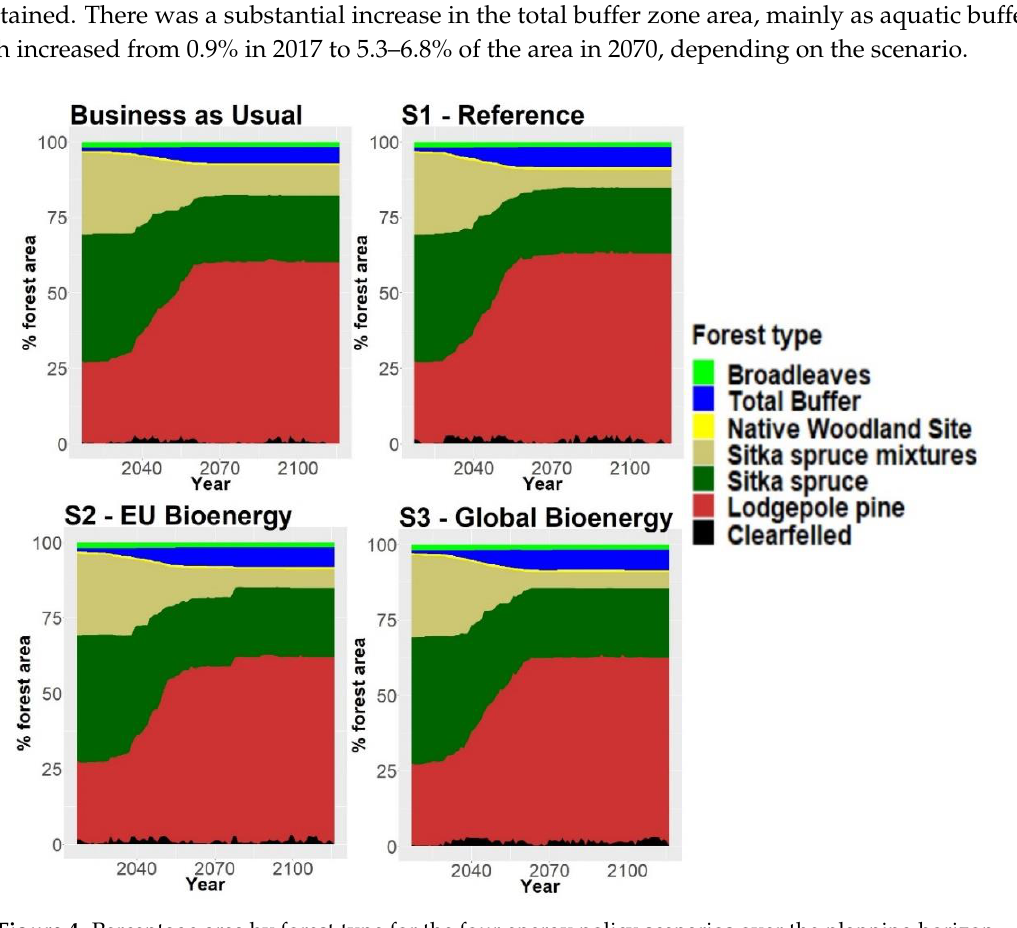
Figure 4. Percentage area by forest type for the four energy policy scenarios over the planning horizon. The Broadleaves group contains both privately owned broadleaves, which can be clearfelled, and Coillte broadleaves, which are managed under a continuous cover forestry regime. Total Buffer contains all freshwater pearl mussel setbacks, aquatic setbacks, and road buffers. Native Woodland Sites are mainly unmanaged native broadleaf stands that are retained for their high biodiversity values; they are separate from the ‘Broadleaves’ group. Sitka spruce mixtures contain all stands dominated by non-lodgepole pine conifers (including Sitka spruce), with broadleaves and/or non-lodgepole pine conifers as secondary or tertiary species. Sitka spruce and lodgepole pine refers to monoculture stands of the respective species, i.e., all the trees are the same species and same age.